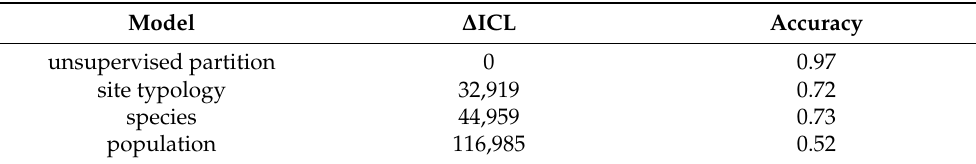
Table 4. Model ranking of candidate models for supervised clustering. Unsupervised partition refers to the best clustering obtained from unsupervised clustering. Accuracy is the classification accuracy of the model.